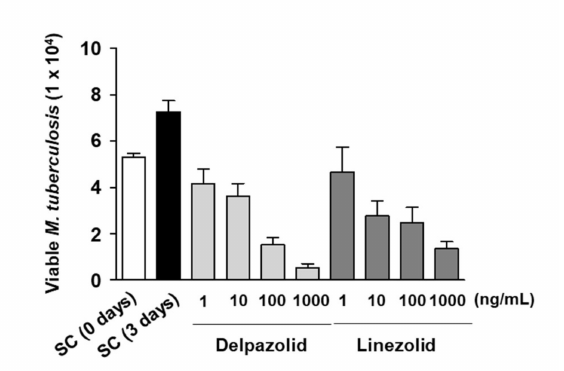
Figure 3. Intracellular activity of delpazolid. The activity of delpazolid on intracellular M. tuberculosis was compared to linezolid in bone marrow-derived macrophages (BMDMs) at three days after infection. The experiment was performed in triplicate, and the results are shown as the mean ± standard error of the mean (SEM). SC, solvent control.